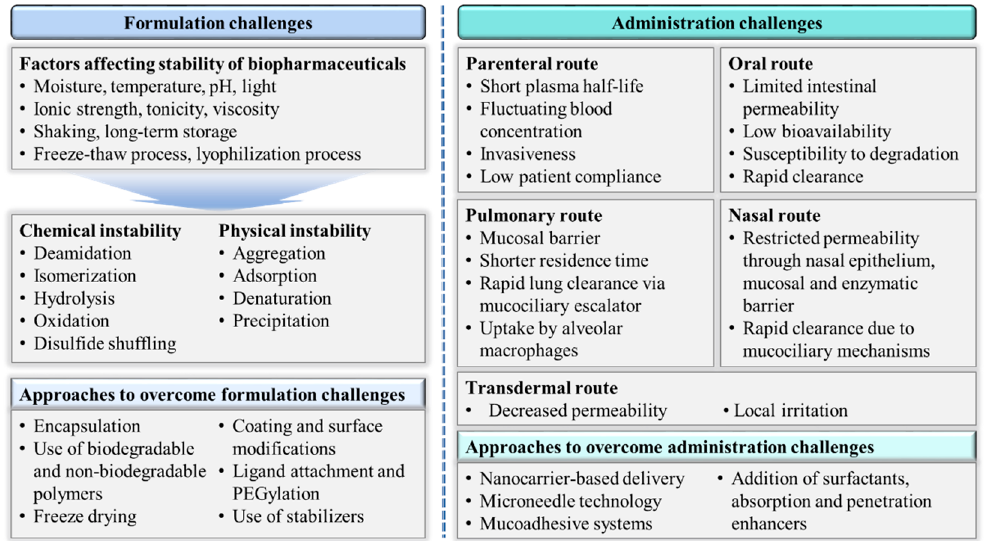
Figure 2. Formulation and administration challenges in delivering biopharmaceuticals.